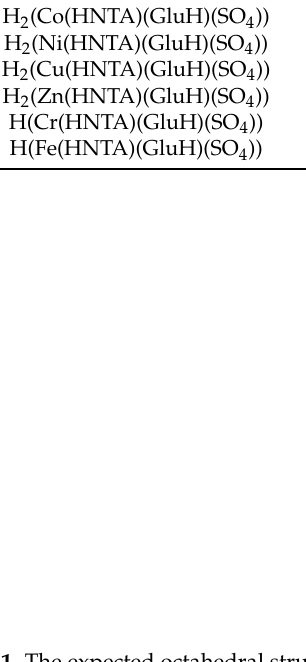
Figure 1. The expected octahedral structure and probable H-bond sites of the ternary metal oligomers: (M(HNTA)(GluH)(SO 4 )) complexes where n = − 2 for M = Cu, Ni, Co and Zn and n = − 1 for M = Cr and Fe .